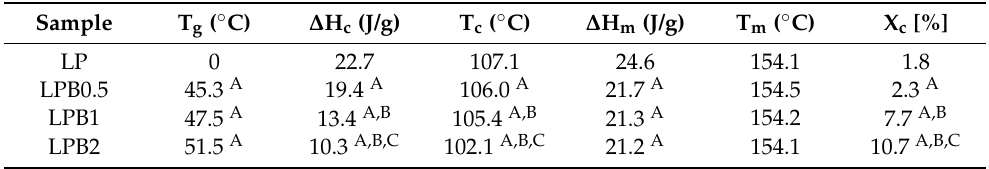
Table 3. DSC data for studied PLA-based films.